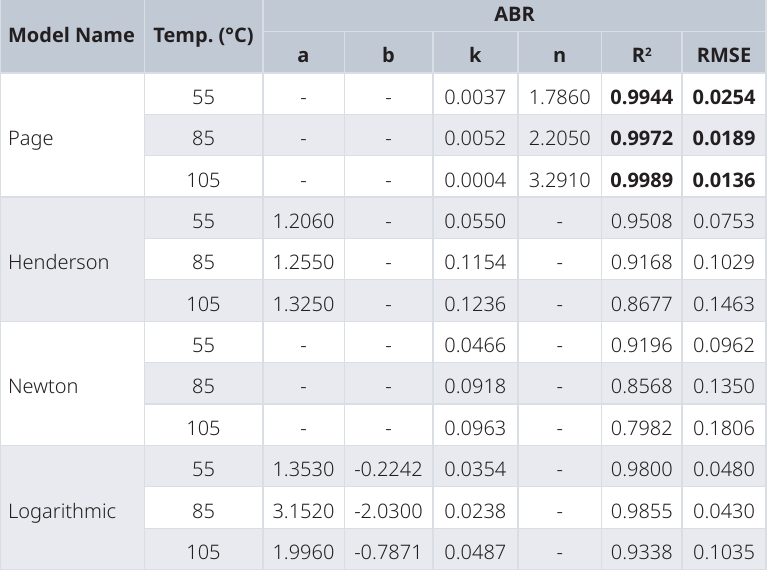
Model Name Temp. (°C)